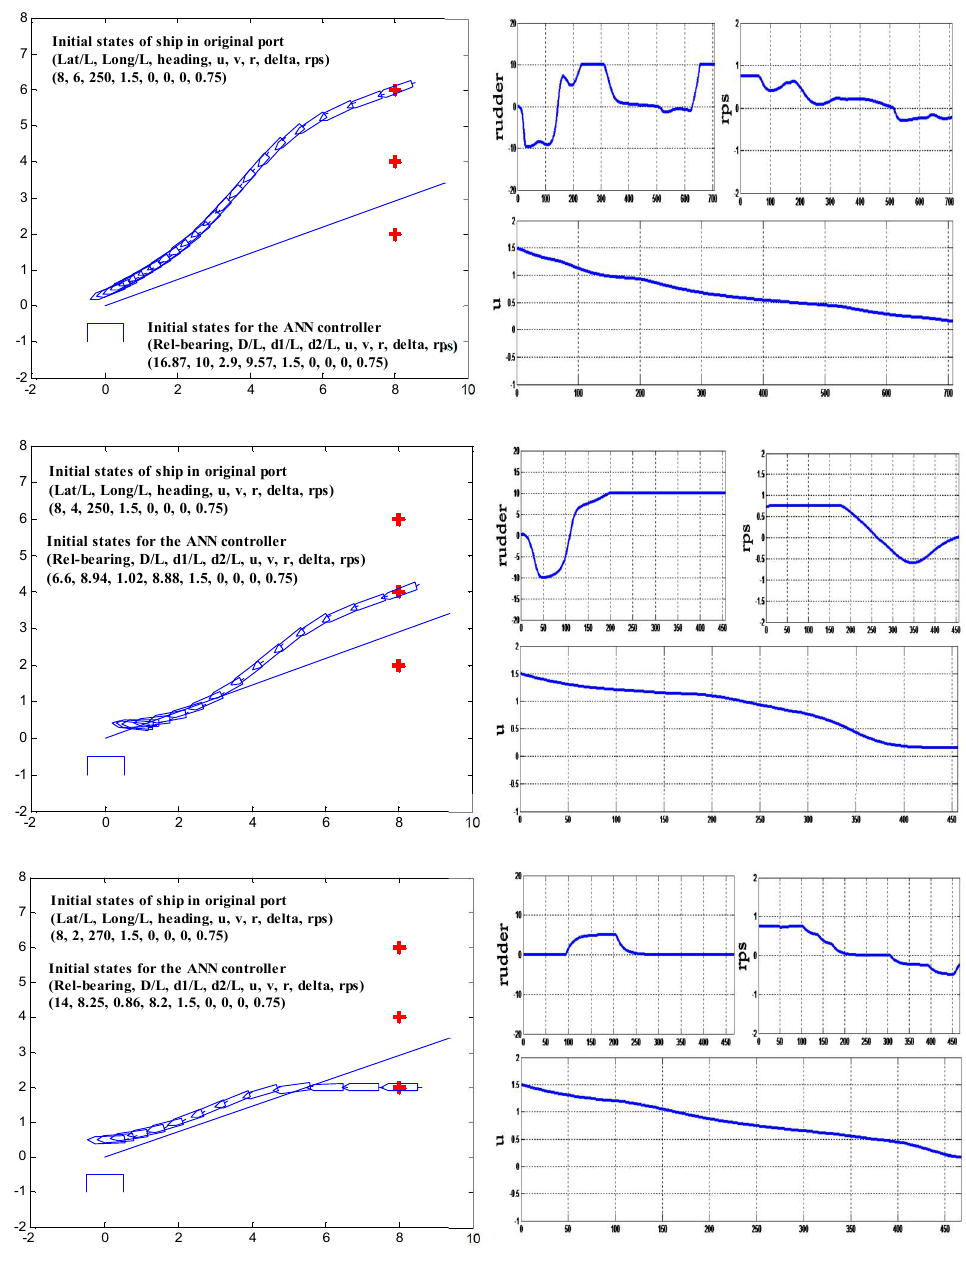
Figure 10. Automatic ship berthing in the original port.